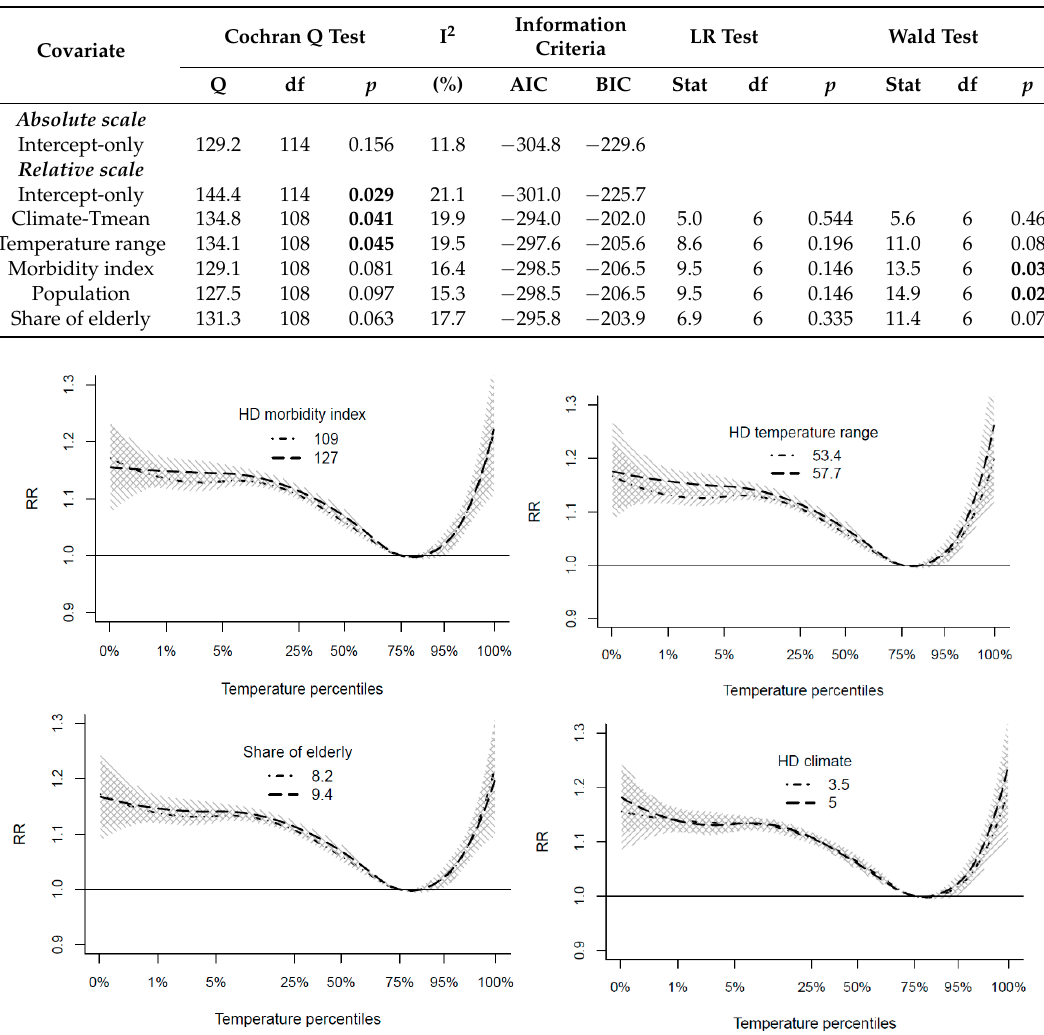
Table 1. Heterogeneity tests on absolute and relative temperature scales. The hospital district (HD)-level meta-analysis covariates are the following: long-term climatological mean temperature; range of daily mean temperatures, THL’s morbidity index, population, and share of elderly (75+ years). Statistically significant p -values with bold.